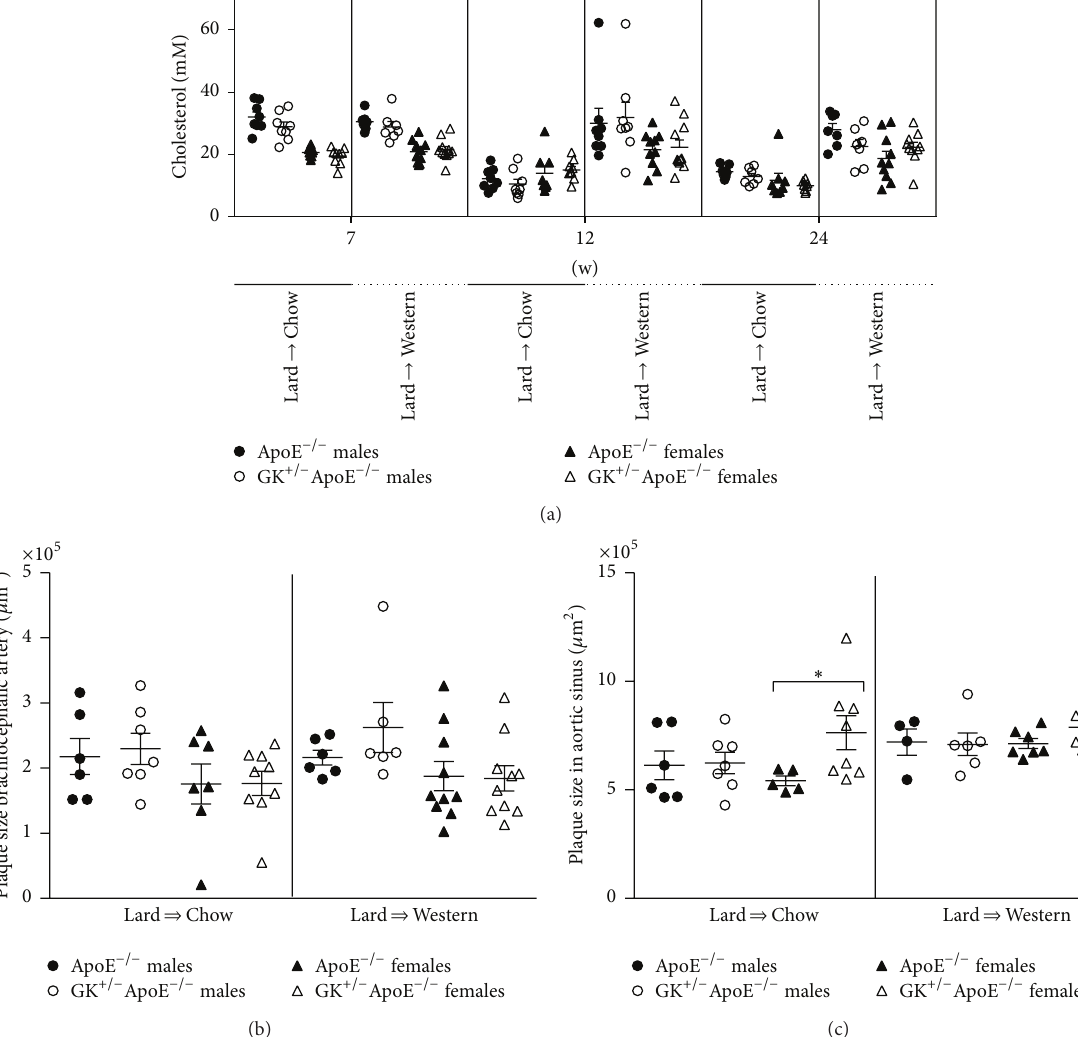
Figure 7: Nonfasting total plasma cholesterol measured after 7 weeks on Lard diet, 4 weeks after diet changed from Lard to WD or Lard to Chow, and 14 weeks after diet changed from Lard to WD or Lard to Chow (a). Plaque size in the brachiocephalic artery (b) and aortic sinus plaque size (c) measured after 14 weeks on Lard to WD or Lard to Chow diet in the atheroregression study. (a) Priming mice with Lard diet induced a 3-fold increase in total cholesterol and the levels remained the same after changing to WD, resulting in similar cholesterol levels at 7 weeks. Conversely, after switching from Lard to Chow diet, the total cholesterol levels decreased significantly in all groups. (b) Plaque sizes in the brachiocephalic artery in both diet groups were comparable, which indicates that the atherosclerosis did not regress on the Lard to Chow diet change. (c). Female GK +/− ApoE −/− mice show equal amount of plaque in the aortic sinus in the Lard to Chow group compared to the Lard to WD despite lower plasma cholesterol levels in both GK +/− ApoE −/− and ApoE −/− mice after dietary change (Lard to Chow diet). Statistical analysis was performed using 𝑡 -test and a 𝑝 value of less than 0.05 was considered significant. ∗ 𝑝 < 0.05